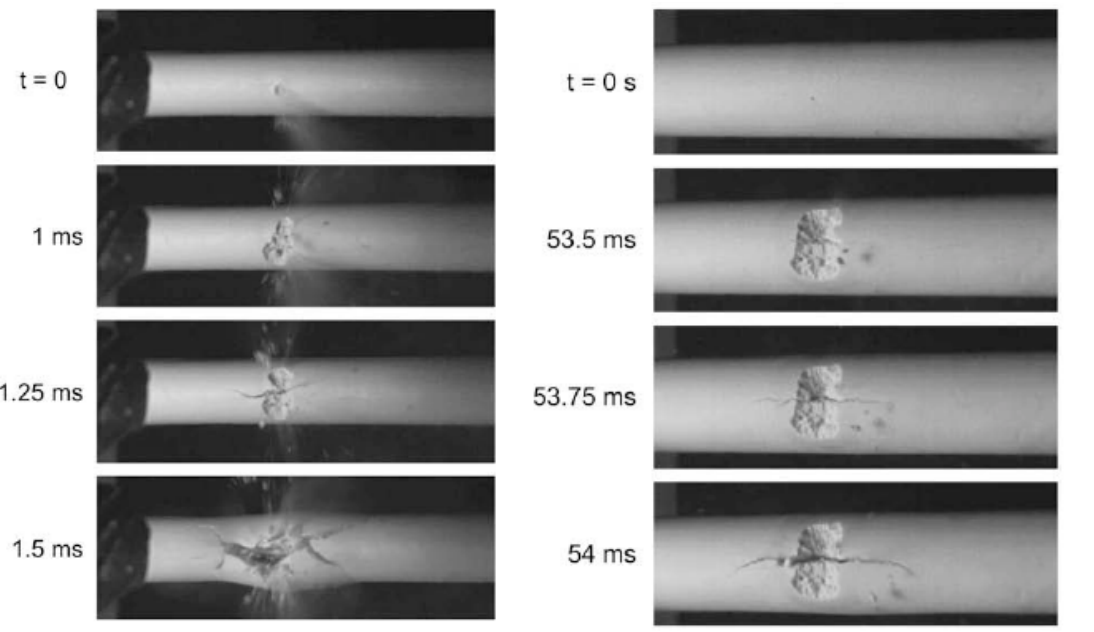
Figure 1. Breakup images for a thin deposit ( left ) and thick deposit ( right ). (Reprinted from [8] with permission from Elsevier).